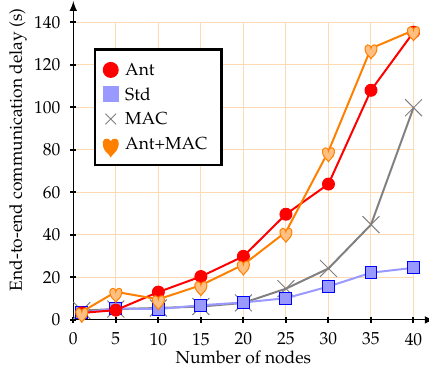
Figure 9. Average end-to-end delay at 1.4 m/s.